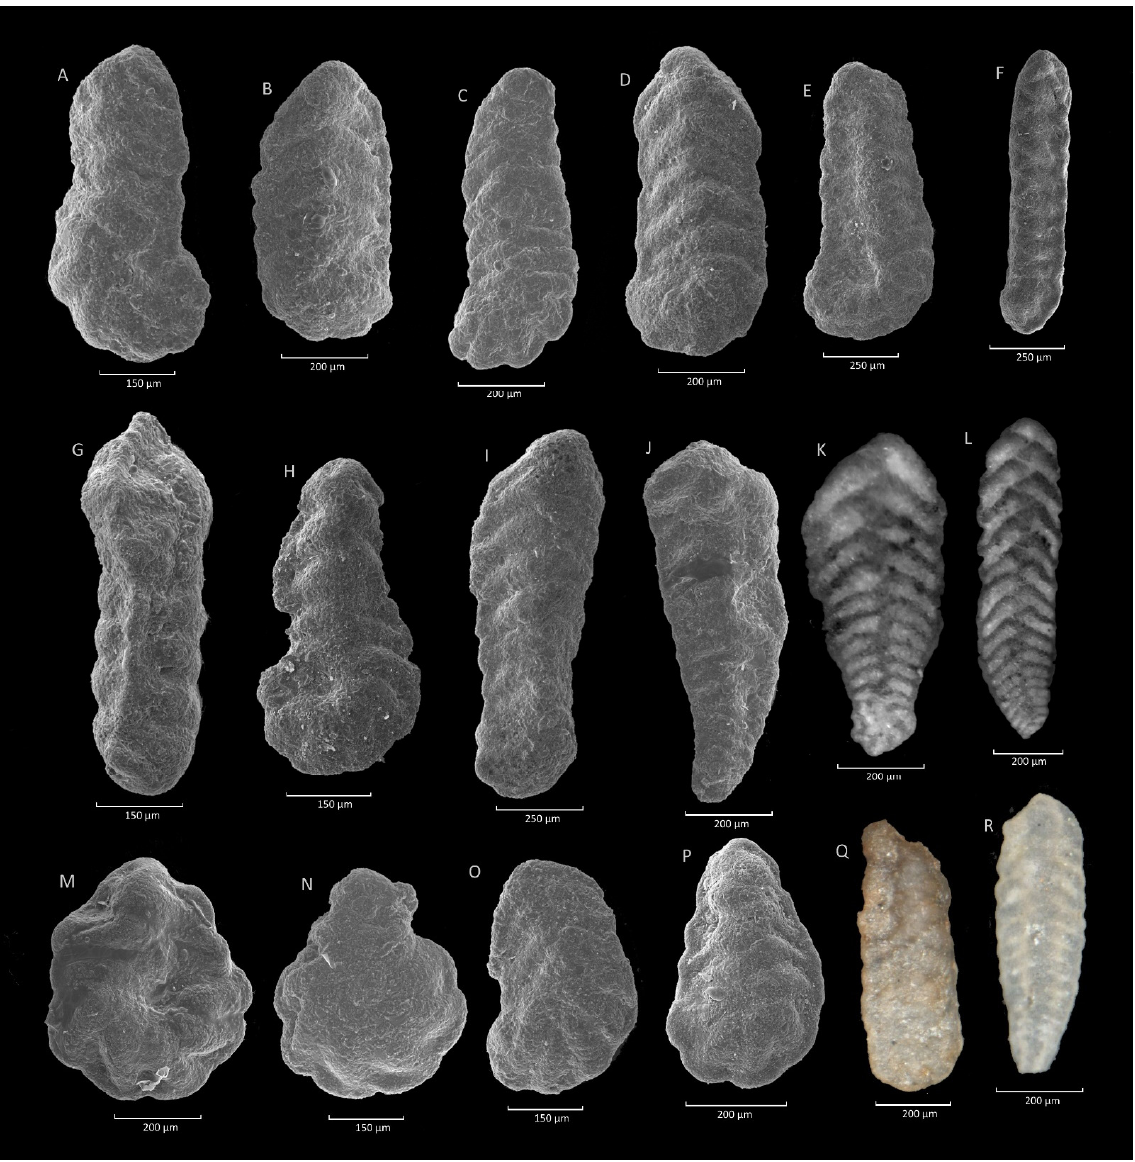
Figure 20. Spiroplectammina spectabilis (Grzybowski). ( A ): Jele´snia section; ( B – D ): Por˛eby-Czarnot ó wki section; ( E – I ): Krzesz ó w section; ( J ): Jele´snia section; ( K , L ): Jezioro Ro˙znowskie section; ( M ): Stradomka section; ( N ): Krzesz ó w section; ( O ): Jele´snia section; ( P , Q ): Olecka section; ( R ): Gorlice